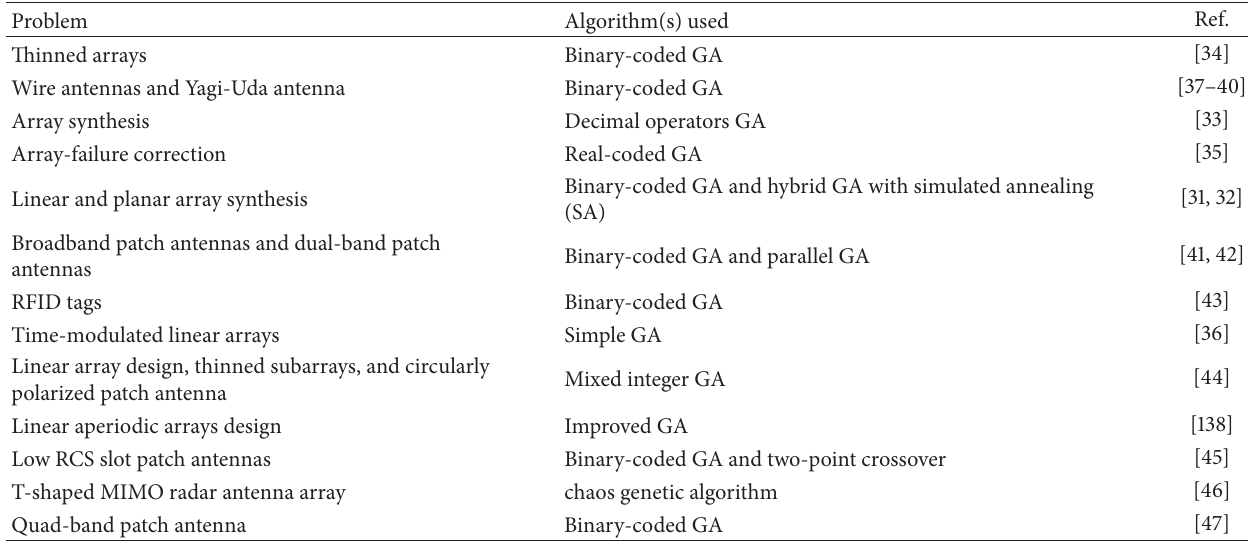
Table 1: Selected journal papers that use GAs for antenna design.